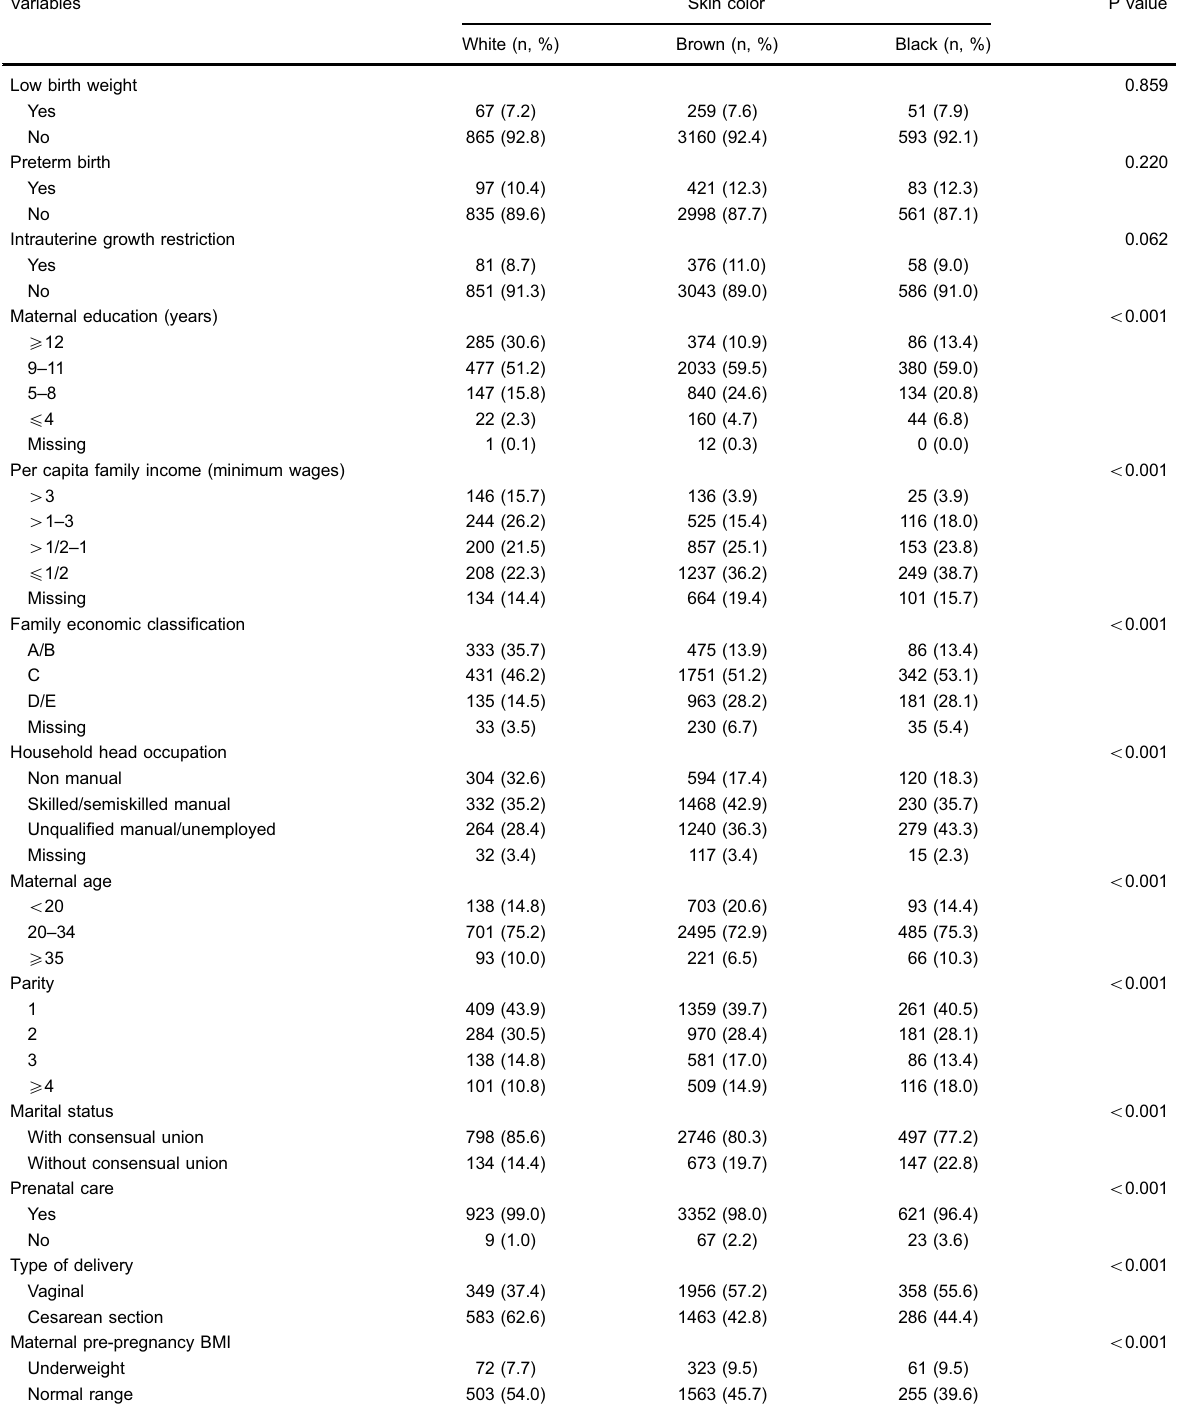
Table 3. Perinatal, socioeconomic, and biological variables according to maternal skin color in the São Luís birth cohort,